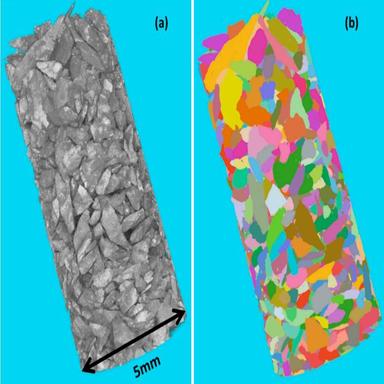
3D volume rendering of a section of the image of the + 0.25 mm-1 mm particles. (a) shows the tomography and (b) is the corresponding labelled particles after separation. Each color is a particle. However, it is possible that different particles are shown by the same color due to random coloring. All 3D volume renderings in this paper are generated using Dragonfly software, a product of Comet Technologies Canada Inc., Montreal, Canada.